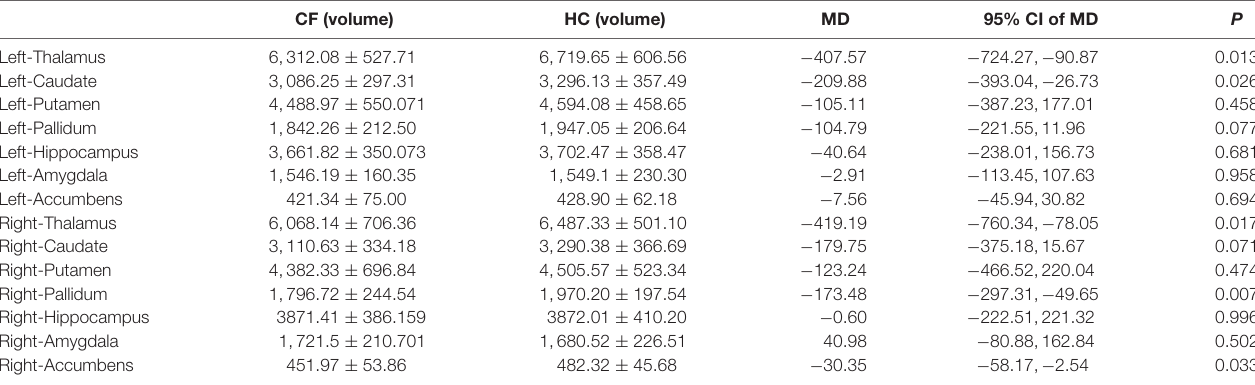
TABLE 2 | Volume of four subcortical nucleus between two groups.